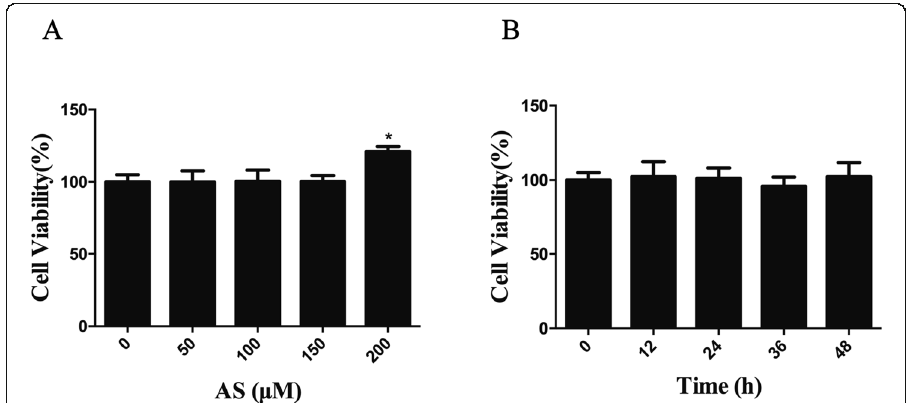
Fig. 2 Effect of asiaticoside on HPMCs viability. Notes: Cell viability was evaluated using CCK-8 assay. Data were expressed as the percentages of living cells versus the control. (A) HPMCs were treated with various dose of asiaticoside (0, 50, 100, 150 and 200 μ M) for 24h or (B) with 150 μ M of asiaticoside for various times (0, 12, 24, 36 and 48h). Abbreviations: HPMCs, human peritoneal mesothelial cells; CCK-8, cell counting